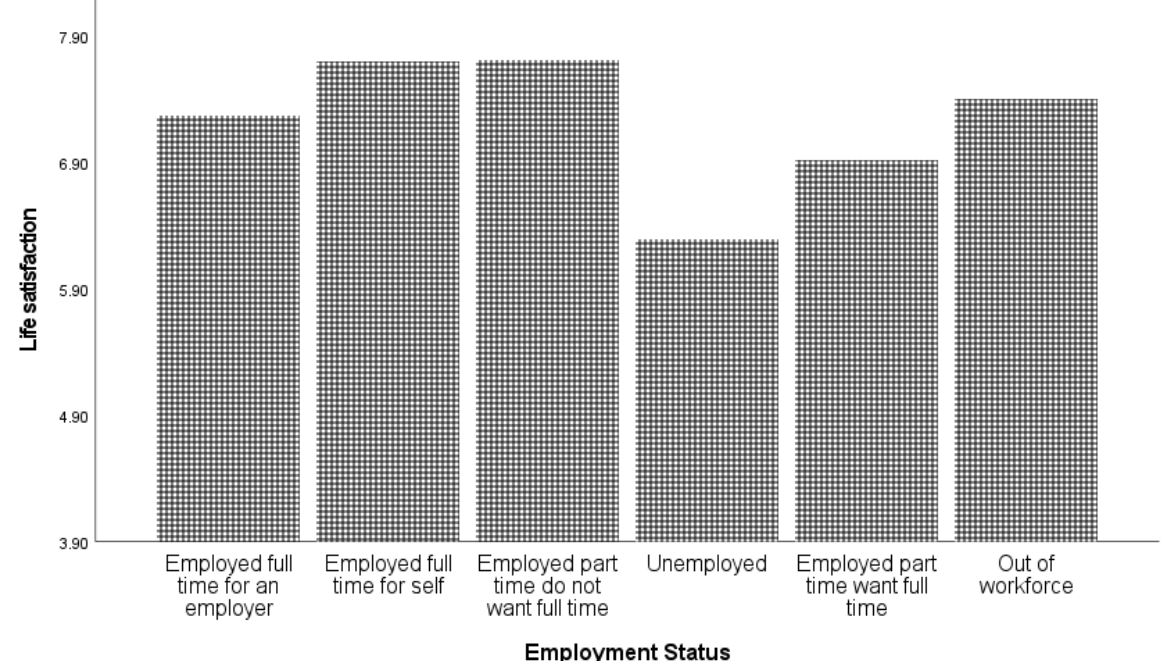
Figure 4. Life satisfaction and employment status.